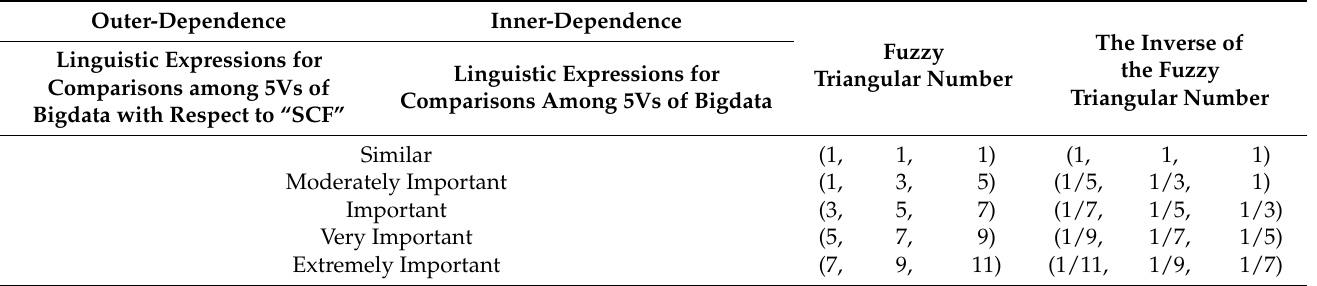
Table 3. Fuzzy analytic network process (ANP) linguistic